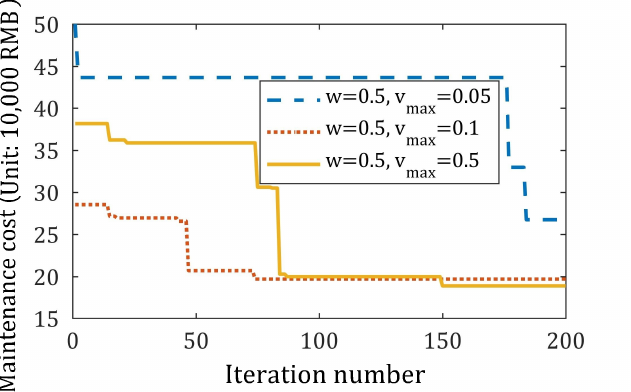
Figure 11. Iterative curves of the optimization objective under different values of v max when N p =